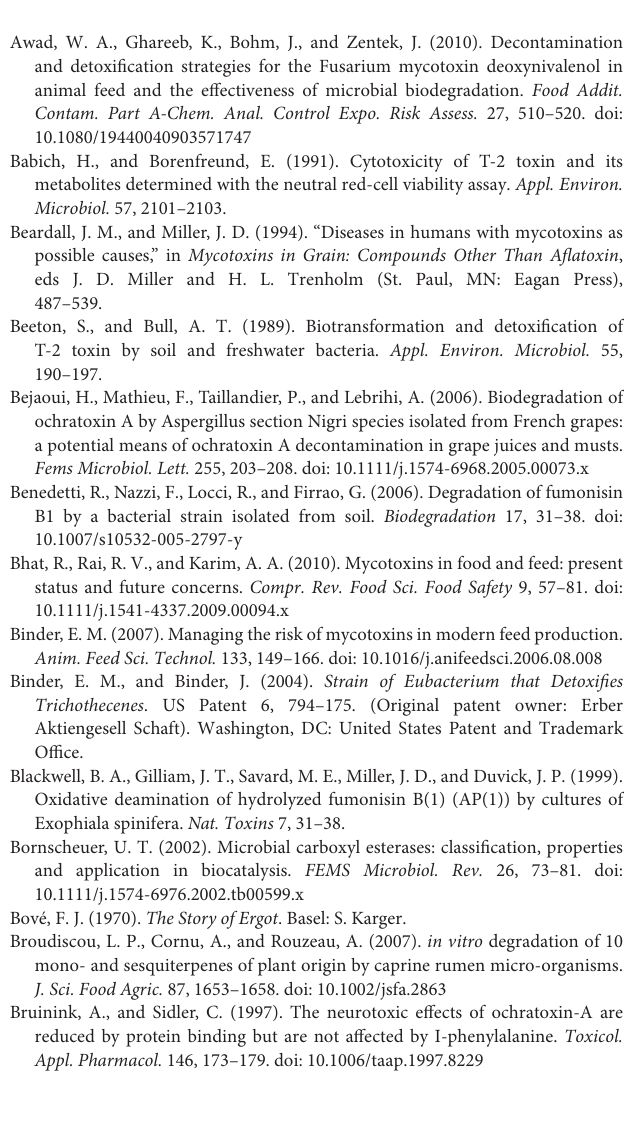
Figure 1 | Reduced toxicity of T-2 toxin by subsequent de-acylation. Table 1 | Toxicity data on mycotoxins and their metabolites. Table 2 | Toxicity of trichothecenes (from most potent to almost no effectiveness observed) (Thompson and Wannemacher,